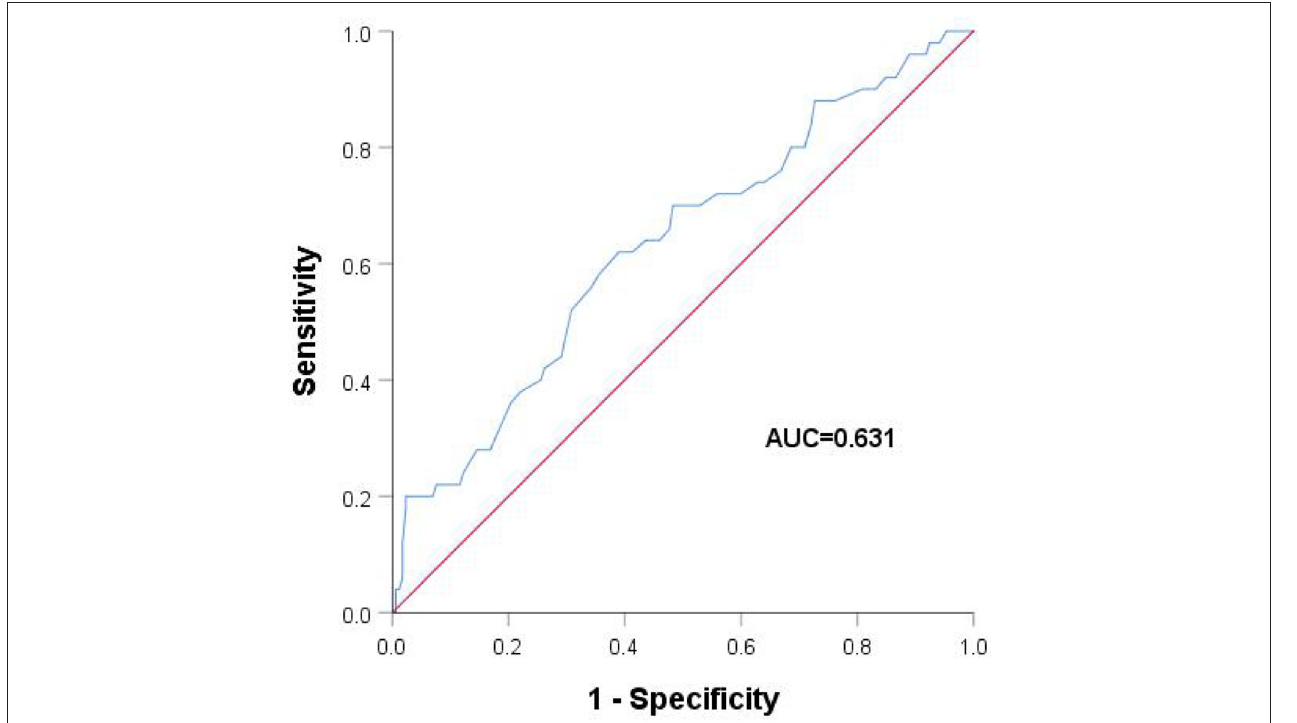
FIGURE 2 | Receiver operating characteristic analysis with different left atrial appendage emptying velocities.